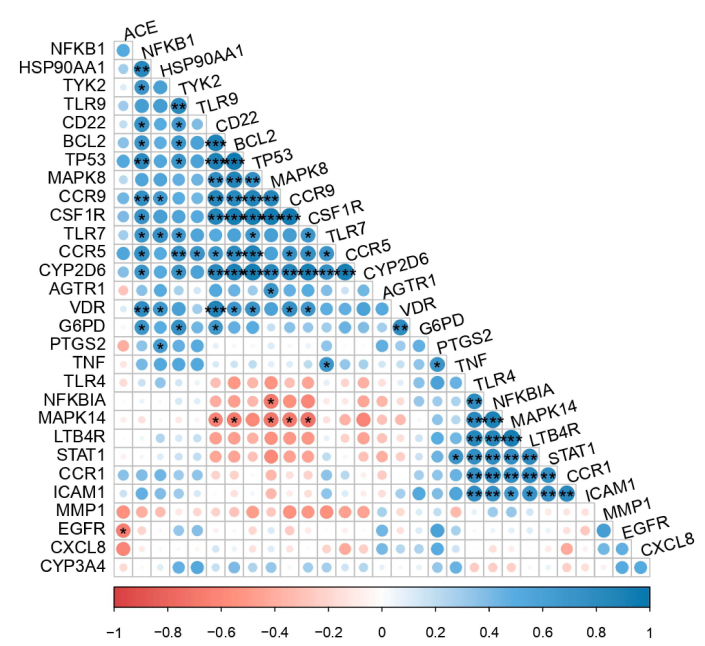
Figure 8. Corrplot indicates the correlationships between the unique COVID-19-associated genes. Blue color—positive correlations, red color—negative correlation, blank/white boxes—insignificant. The size of the circle and the color intensity are directly proportional to the correlation coefficients. In addition, p -value cutoff (*: p ≤ 0.05; **: p ≤ 0.01; ***: p ≤ 0.001) is to set a threshold for the significant correlation.